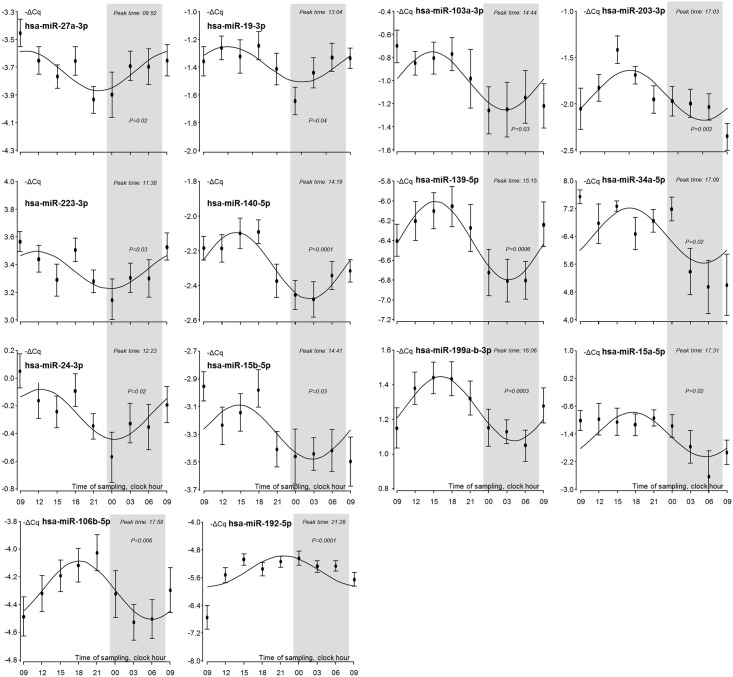
Diurnal miRNAs.Sleep periods are indicated in grey. Individual points represent the mean and SEM of the values of the 24 test individuals.